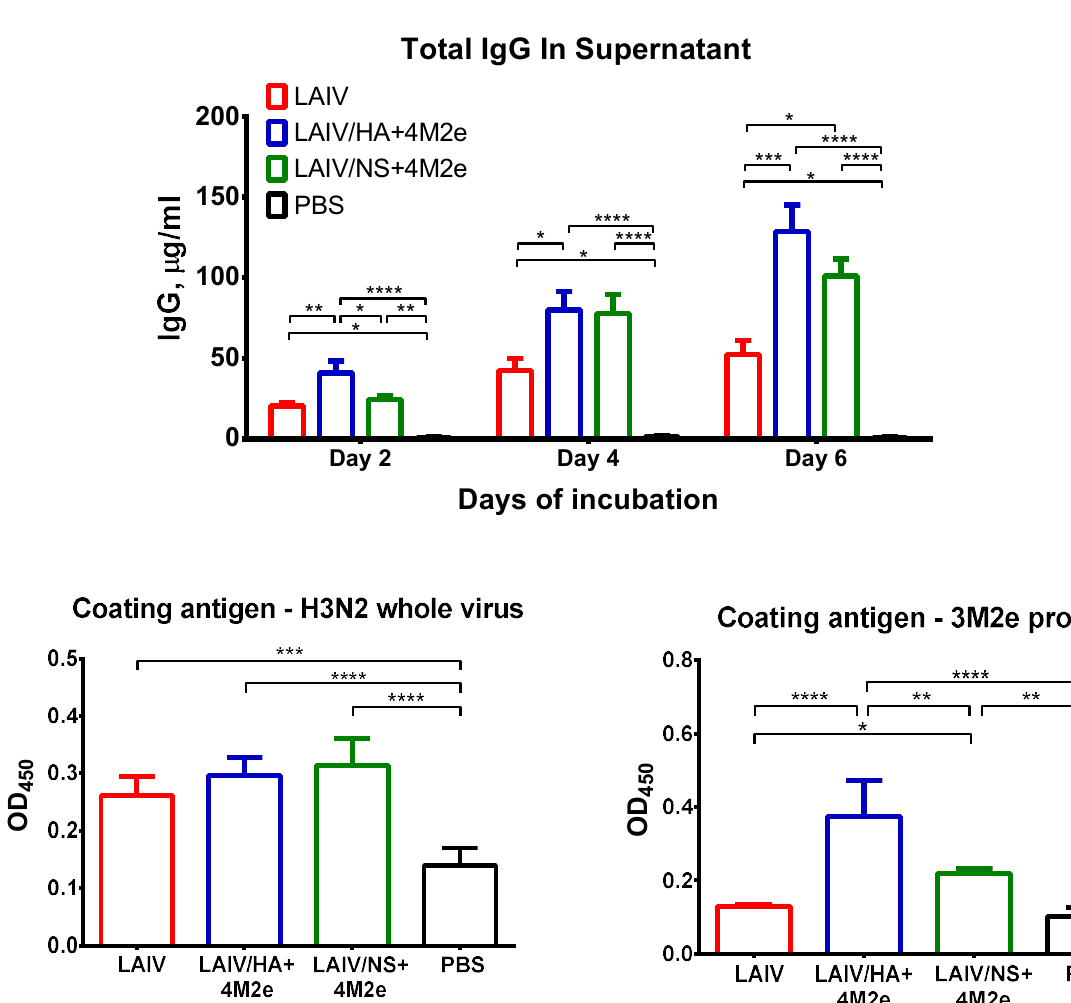
Figure 10. Antibodies produced by MLN cells. ( A ) Mediastinal lymph nodes were collected 5 days post-challenge and single-cell suspensions were incubated in culture medium without addition of any antigen. Supernatants were collected on days 2, 4 and 6 and the level of total IgG was determined by ELISA from the regression curve of the standard ferret IgG titration. ( B ) The same isolated MLN cells were cultured in ELISA plates coated with indicated antigens, followed by development with secondary anti-ferret IgG antibodies and chromogenic substrate. Data were analyzed by two-way ( A ) or one-way ( B ) ANOVA with Tukey’s post-hoc multiple analyses test. * p < 0.05; ** p < 0.01, *** p < 0.001, **** p < 0.0001.